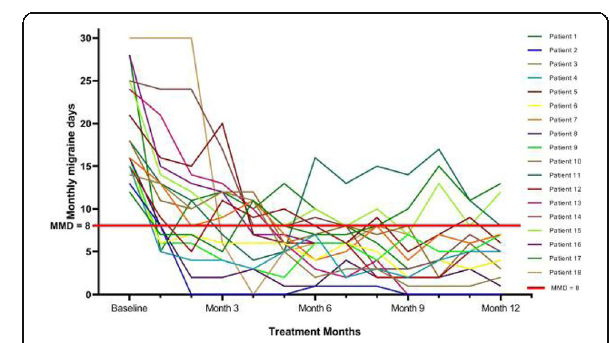
Fig. 2 (abstract P0298). See text for